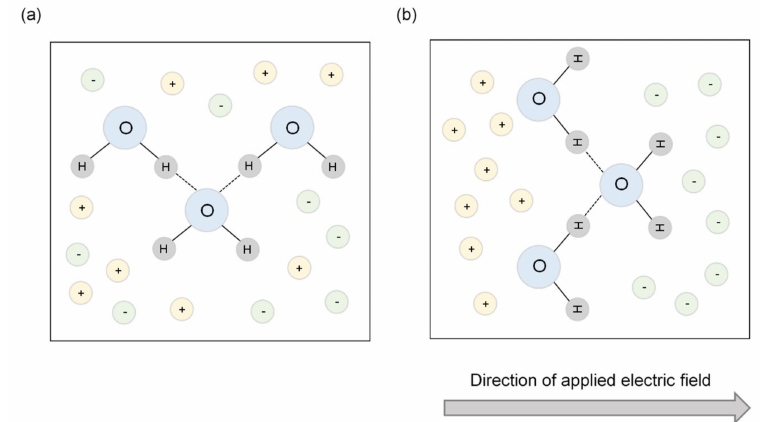
Figure 1. The water molecule with positive and negative charges: ( a ) the natural condition; ( b ) the arranged condition due to the applied electric field. The stored energy of the water molecule is a real part of the dielectric constant, and the energy loss initiated by environmental ions (positive and negative ions) is described as the imaginary part of the dielectric constant. The dotted line shows the hydrogen